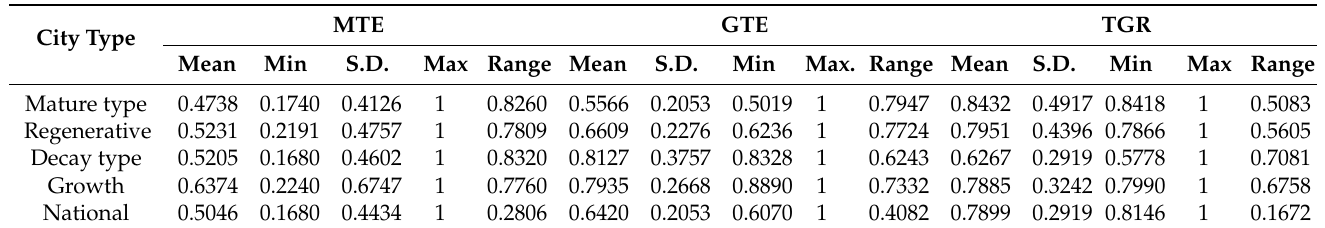
Table 2. Statistical description of regional innovation resource allocation efficiency from 2006 to